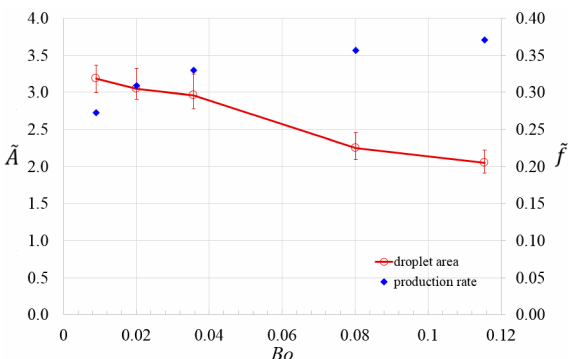
Figure 5. Dimensionless averaged droplet area and dimensionless production rate at different Bond numbers by controlling the rotation speed.